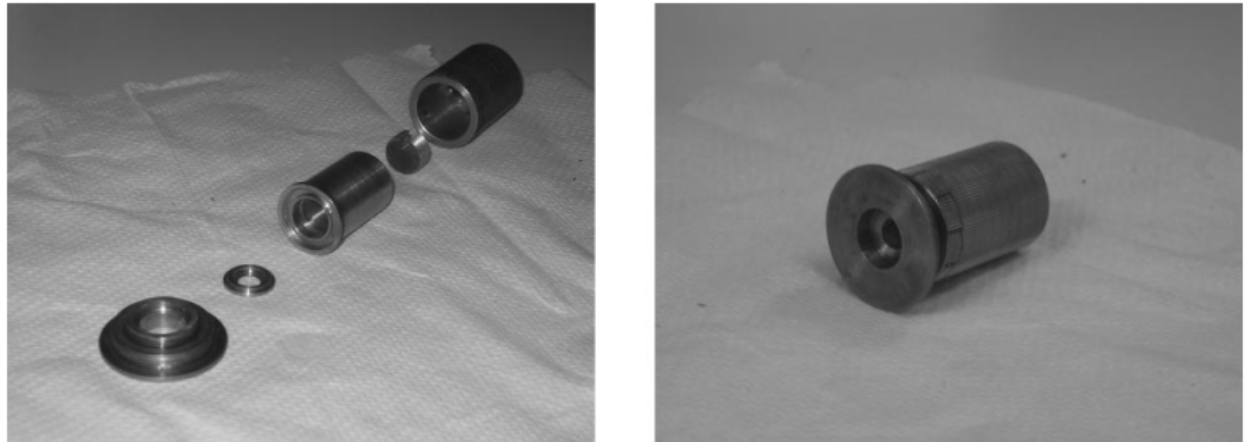
Figure 5. Photograph of the device used by Norrby et al.: ( Left ) individual parts; ( Right ) fully assembled device. An interesting feature of this eye model is the fact it is all its components are compacted into a small enclosure, whose size resembles a real eye. Applied Optics 2007, 46, 6595–6605 ([23]). Originally published by and reprinted with permission from Optica Publishing Group.